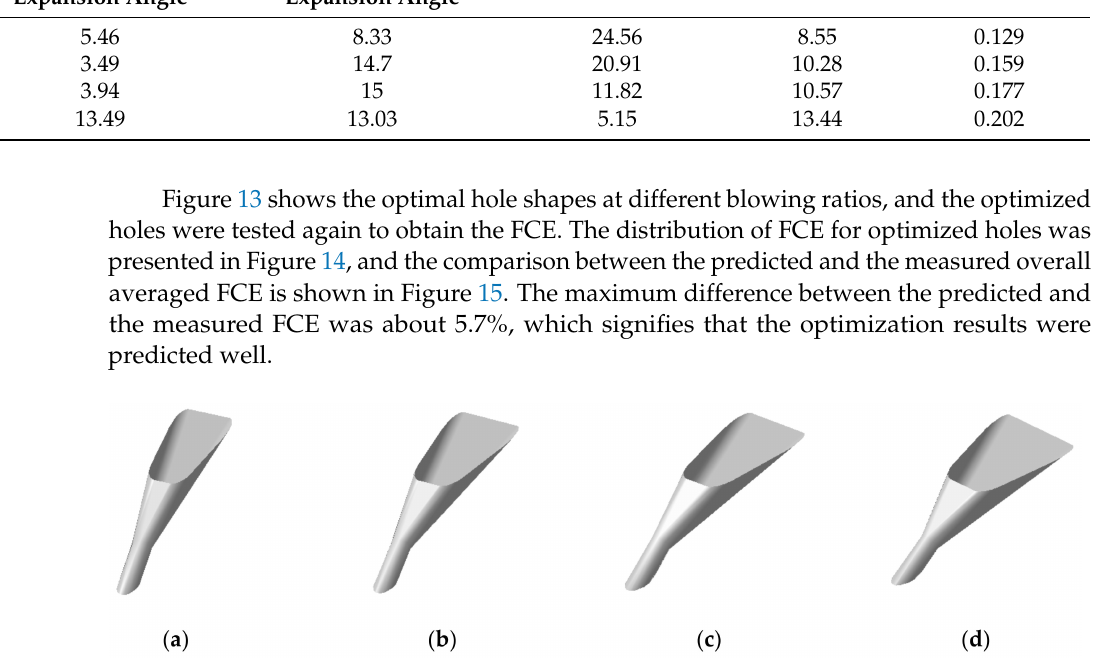
Figure 13. Shapes of optimized asymmetric laidback fan shaped hole at different blowing ratios: ( a ) optimized hole at M = 1.0 (5.46-8.33-24.56); ( b ) optimized hole at M = 1.5 (3.49-14.7-20.91);